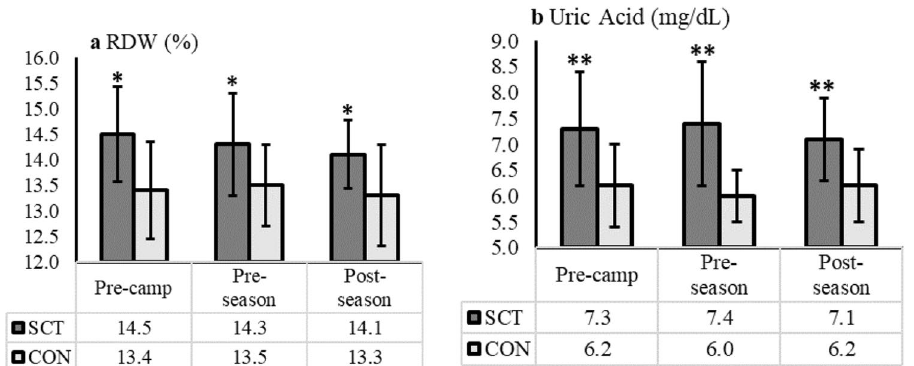
Figure 3. The red blood cell distribution width (RDW; a ) and uric acid ( b ) across the visits by groups (SCT and CON). Dark grey bars are sickle cell trait players (SCT), and light grey bars are position-matched control group (CON). SCT players exhibited significantly greater RDW and uric acid across all visits compared to CON; *Significant differences p < 0.05. **Significant differences p <